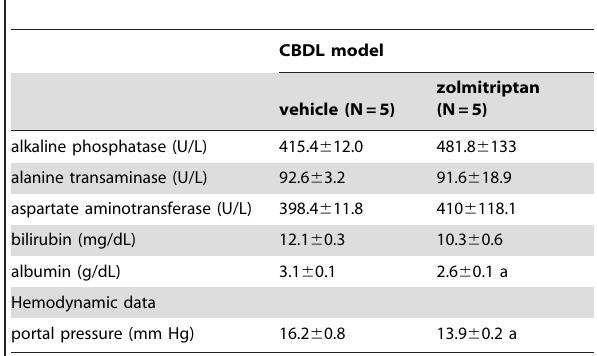
Table 2. Biochemical data and hemodynamic parameters in CBDL rats after chronic treatment with zolmitriptan or